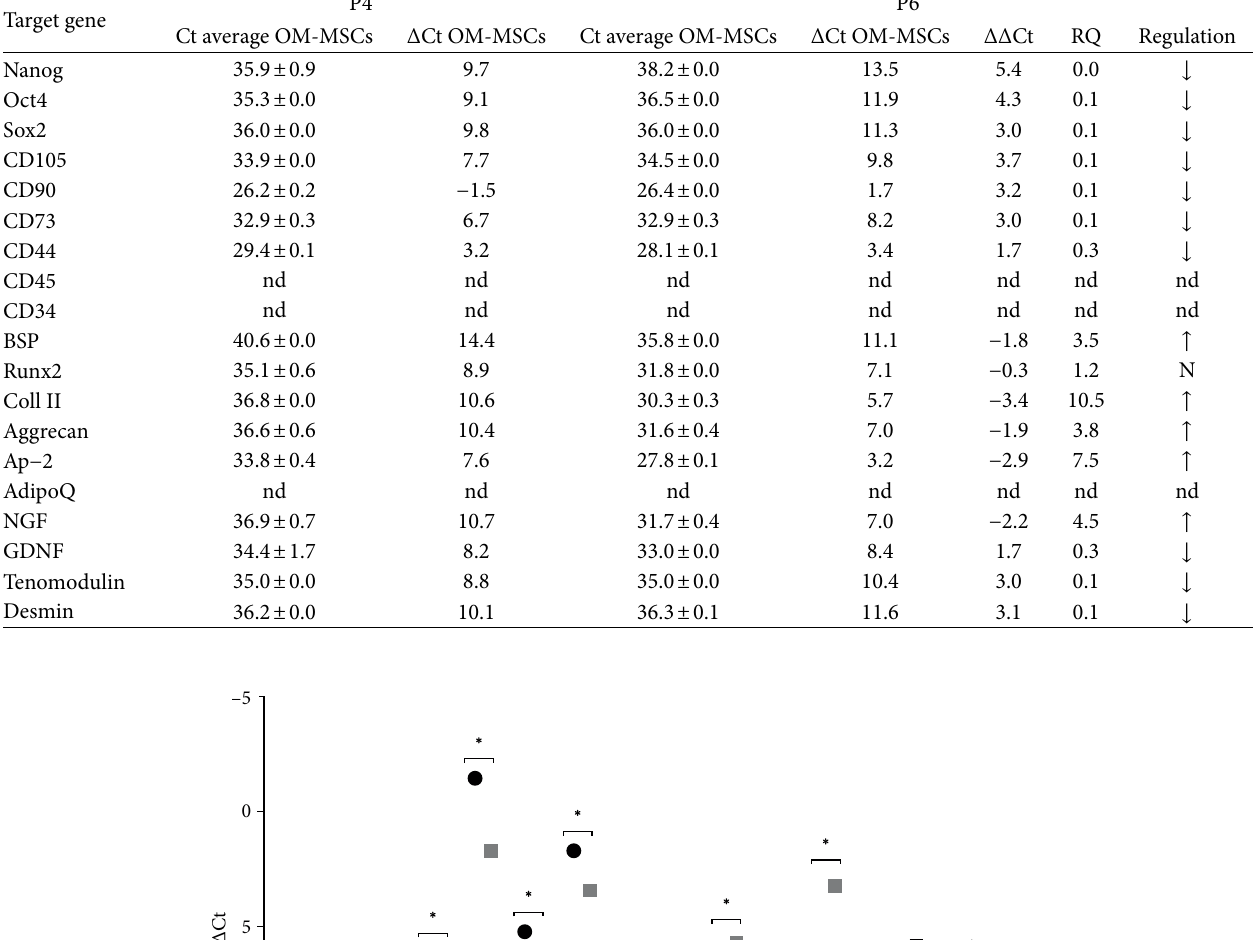
Table 2: Ct, ΔCt, ΔΔCt and RQ values for all genes under study for P4 and P6. nd = nondefined.